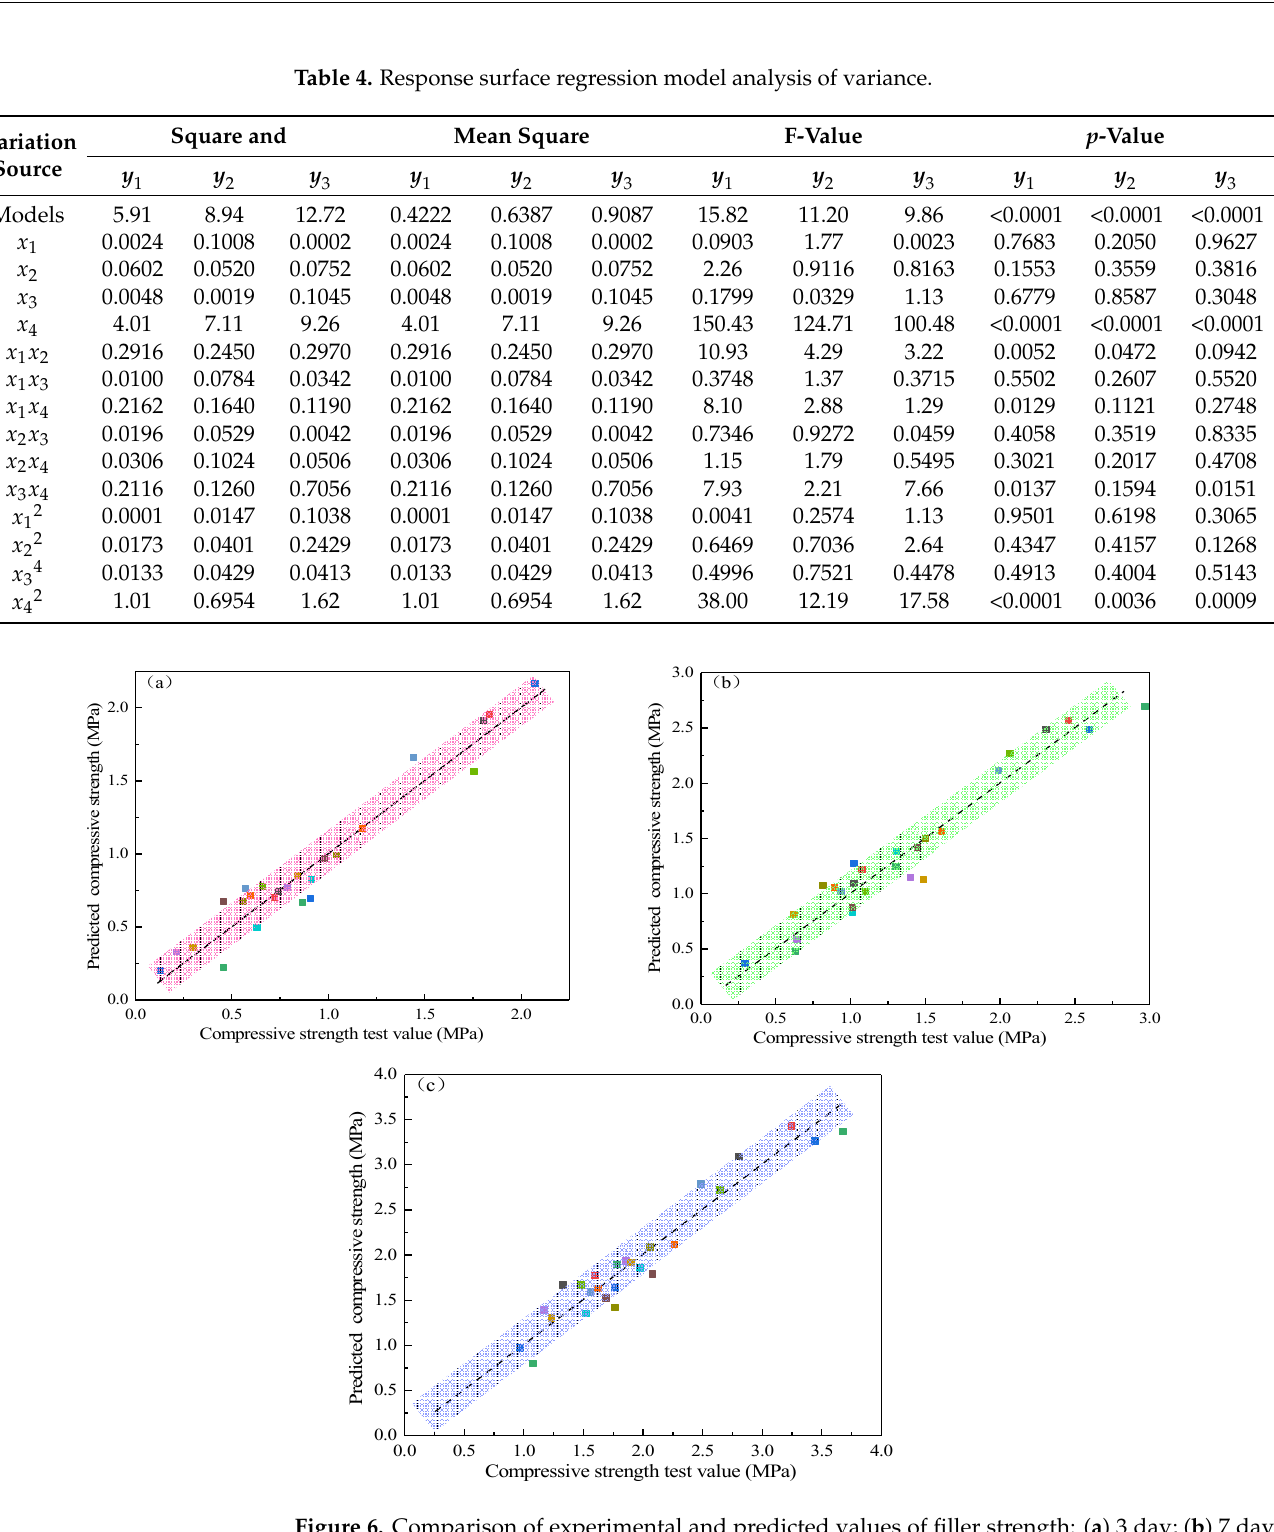
Table 4. Response surface regression model analysis of variance.